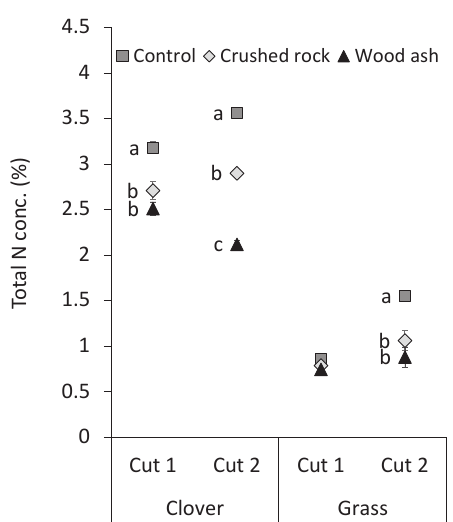
Fig. 2. Total N concentration in red clover and perennial ryegrass. Data are given as Least-Squares Means, error bars indicate SEM, and different letters (a-c) indicate significant differences between treatments for each crop species at each cut ( p ≤0.05; n=4).